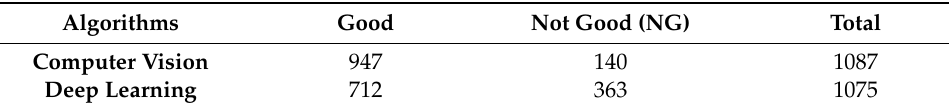
Table 4. Dataset Details of the Acquired Industrial